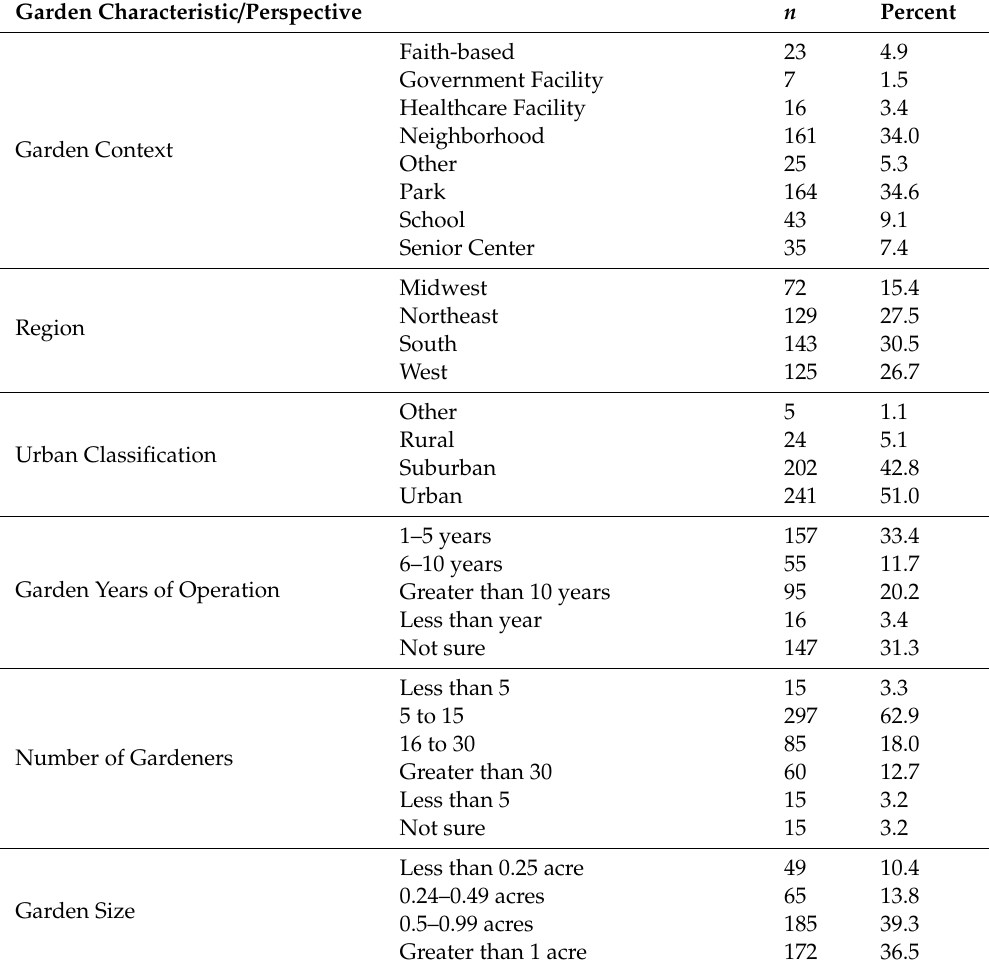
Table 1. Community Garden characteristics reported by